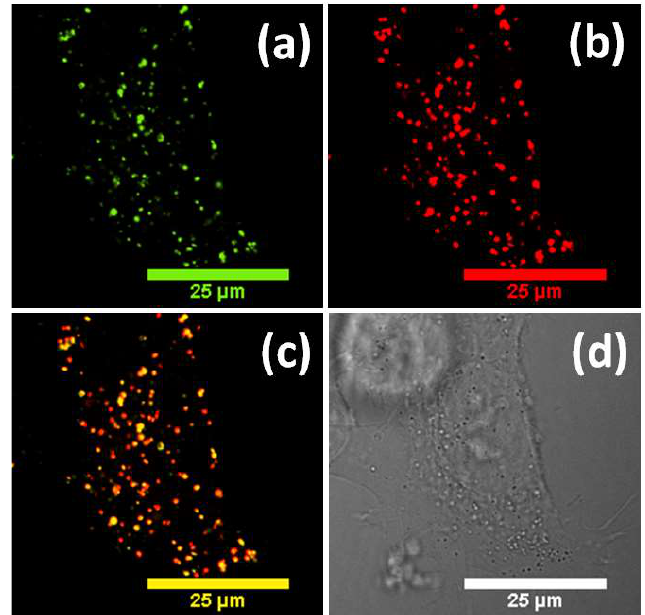
Figure 3. Fluorescence confocal microscope images of the MO3.13 cells incubated with probe 3b (200 nM) for 30 min in the presence of LysoTracker TM Green DND-26 (70 nM). Figures represent the staining of the LysoTracker TM Green DND-26 ( a ), staining of probe 3b ( b ), composite image ( c ), and the bright field ( d ). Probe 3b was excited with 561 nm laser line and the LysoTracker TM Green was excited with 488 nm laser line. The emission filter settings were set up to collect from 495 to 530 nm (LysoTracker TM Green) and 575 to 750 nm ( 3b ), respectively.